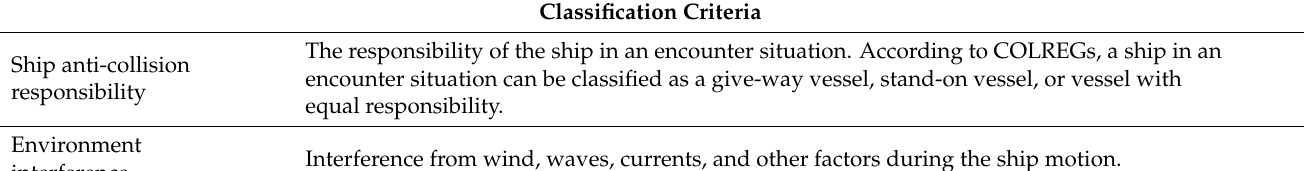
Table 1. Classification criteria from the literature review. Classification Criteria